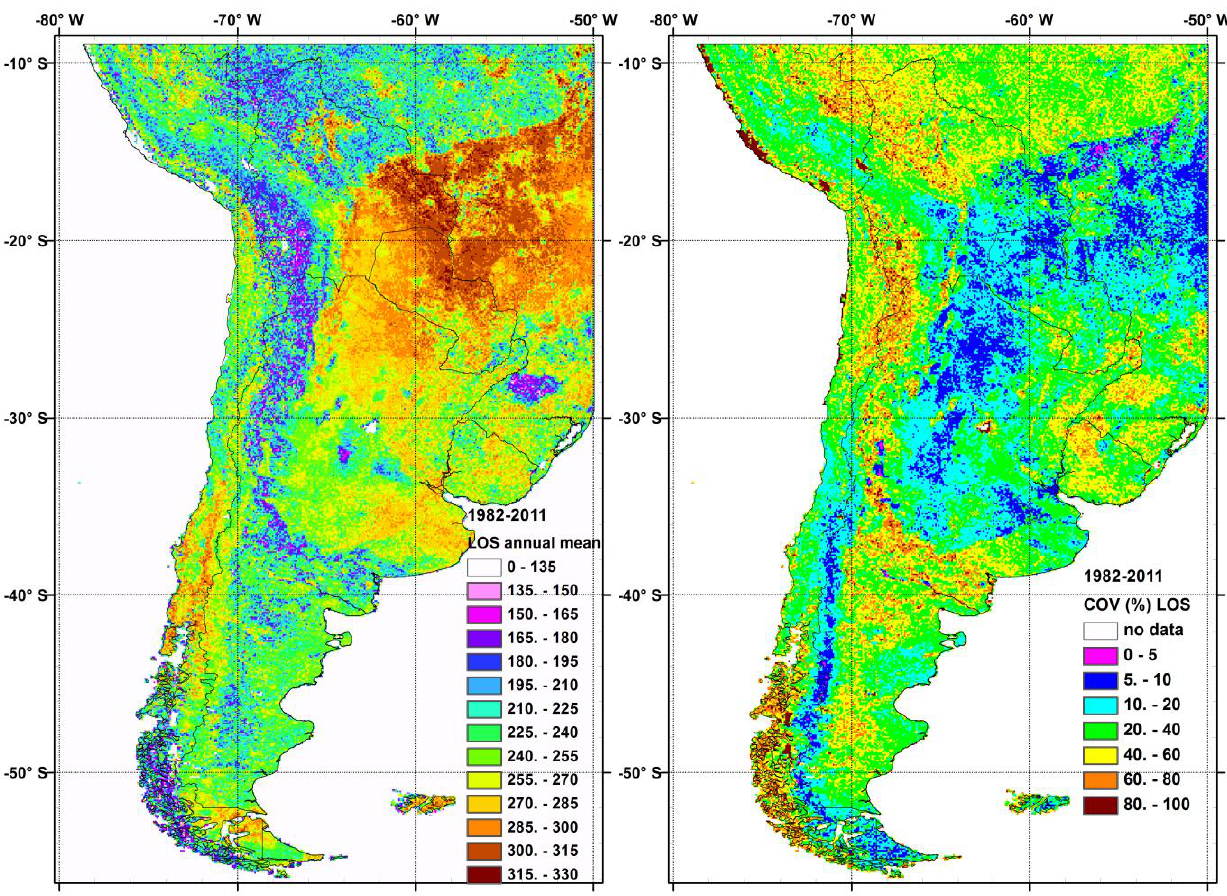
Figure 7. Thirty-year mean LOS and coefficient of variation based on the phenology of thirty years of NDVI